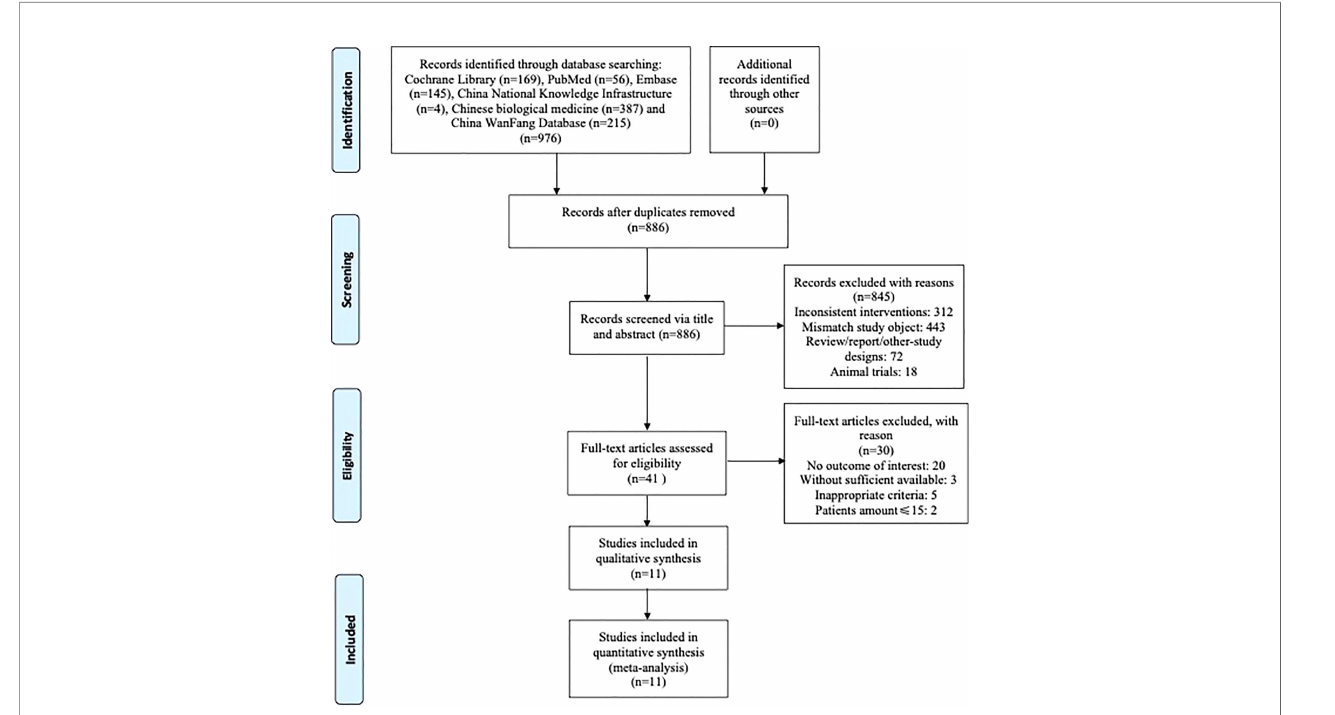
FIGURE 1 | Flow diagram indicating the process of selecting articles for meta-analysis and the steps of network pharmacology